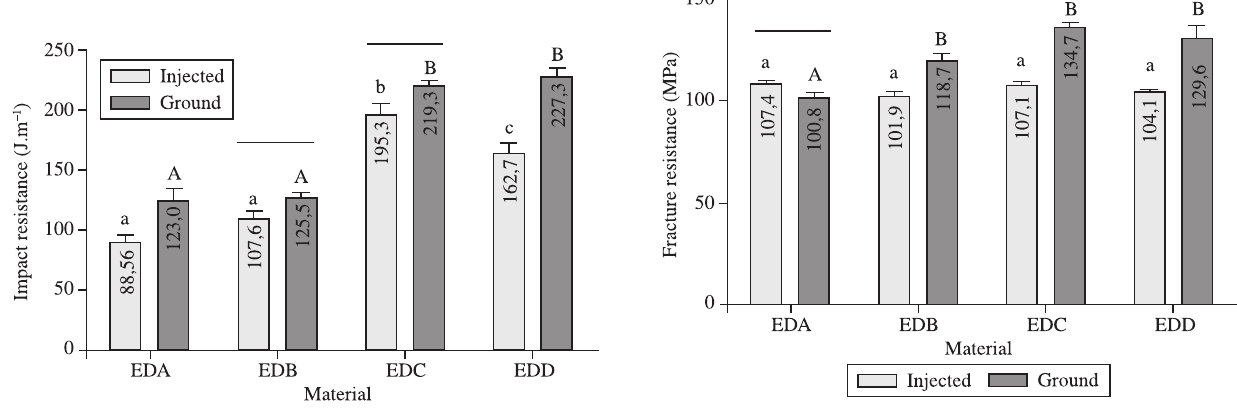
Figure 3. Fracture resistance. Comparison (2-way ANOVA - Bonferroni - p < 0.05) of commercial and experimental materials (ground and